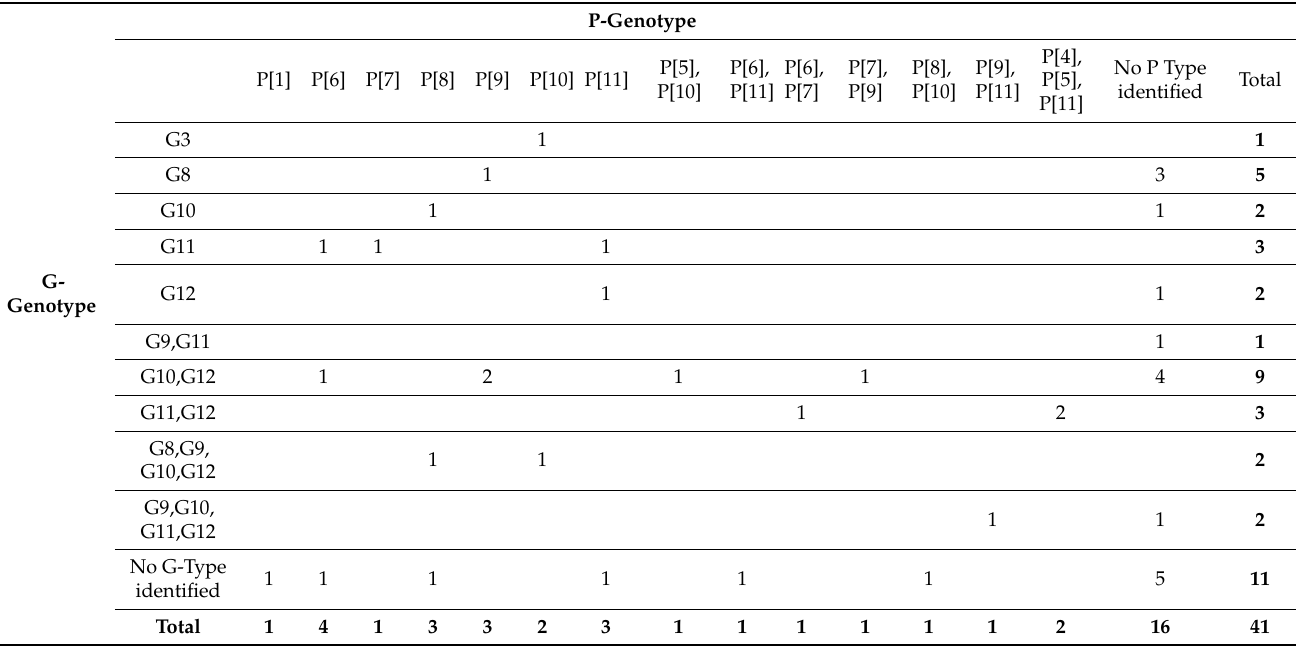
Table 3. Rotavirus G- and P-genotypes found in the stool of domestic animals in Masaka District, Central Uganda, 2013 and